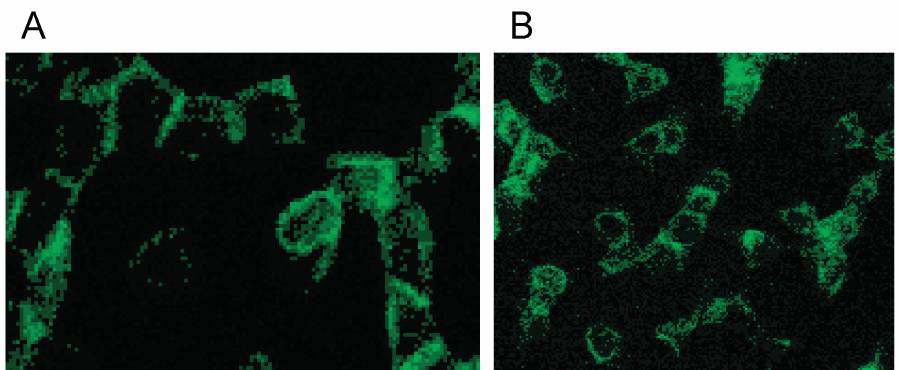
Figure 14. Band 4.9 stained erythrocytes after suspension of erythrocytes in ( A ) an Iodixanol/plasma mixture or ( B ) in an Iopromide/plasma mixture (RCM 30% v / v ) (reprinted from reference [23], Copyright 2013, with permission from IOS